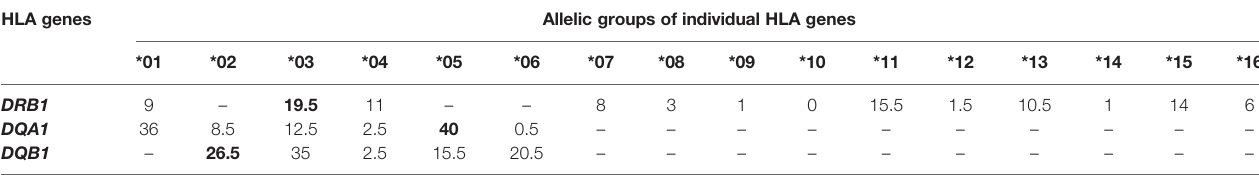
Data are given as %, frequencies of the risk variants of the particular genes are in bold. The asterix represent an established form of HLA genes nomenclature in accordance with the current HLA nomenclature (http://hla.alleles.org/nomenclature/nomenc_updates.html).